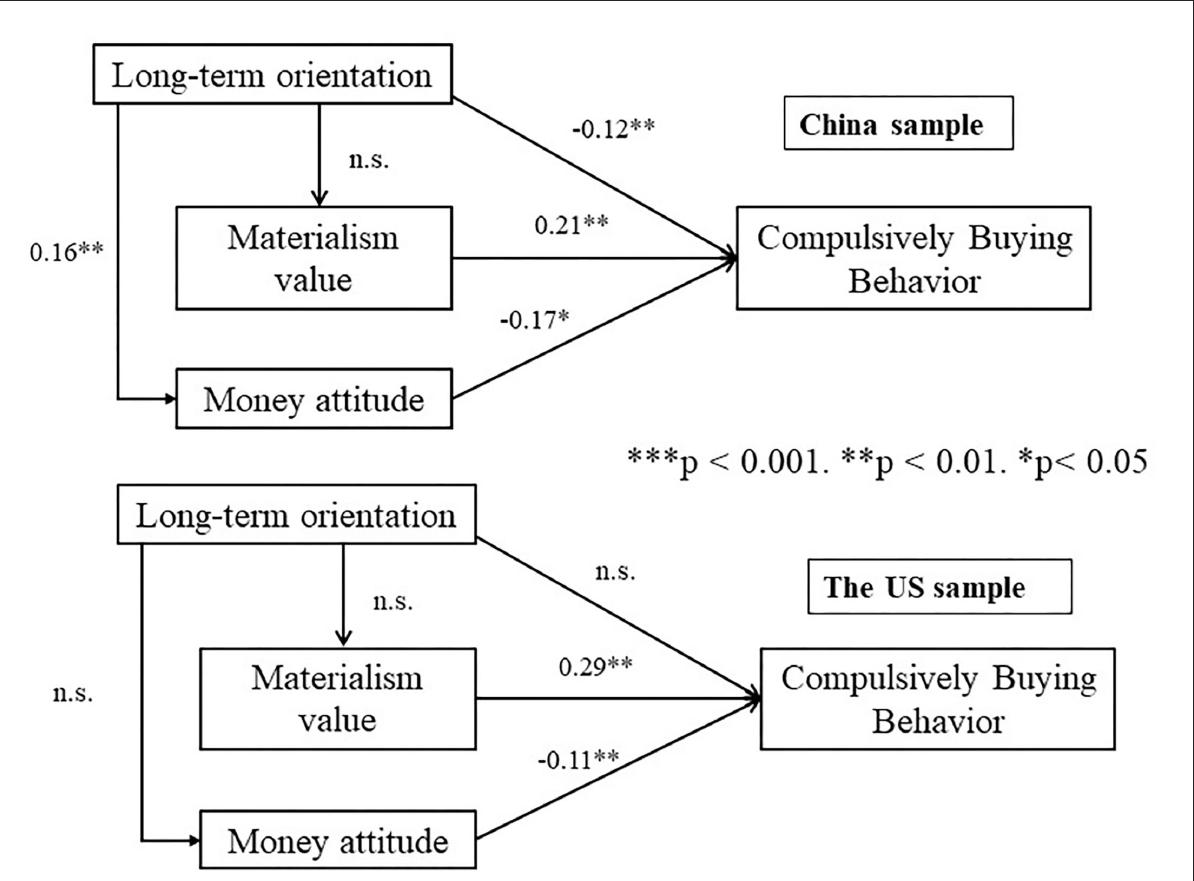
FIGURE2 Multigroup regression weights in the conceptual model. * p < 0.05, ** p < 0.01, *** p < 0.001, n.s. means no significant